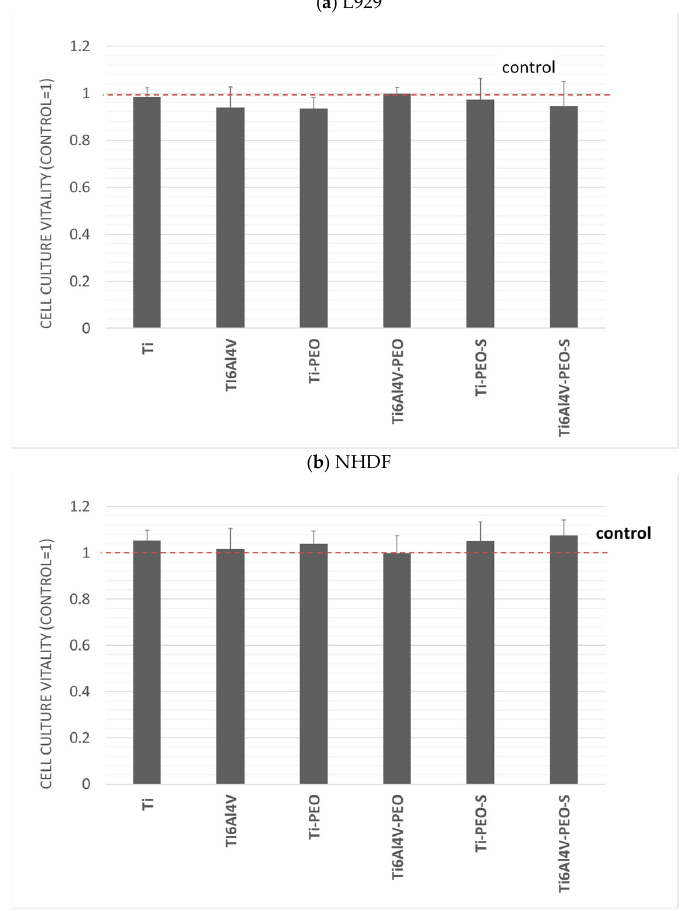
Figure 3. ( a ) cell culture vitality of the L929, and ( b ) cell culture vitality of the NHDF. Evaluation of the cytotoxicity of the tested biomaterials. Results are averages from 5 independent experiments, presented as a ratio of the value obtained in the test culture to the control. Red line—control.